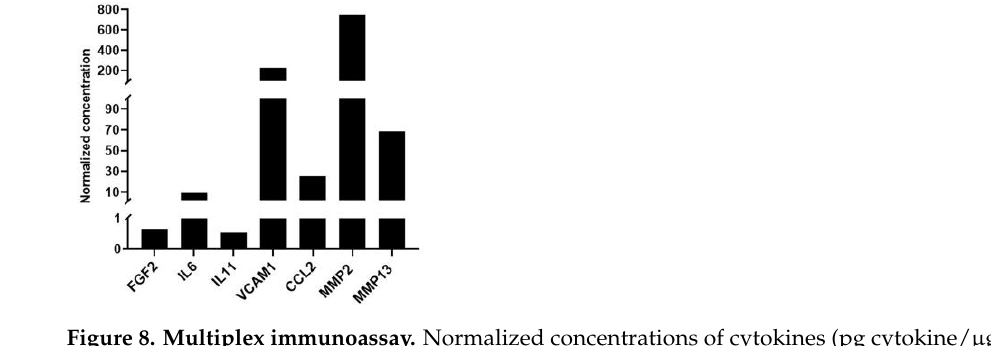
Figure 8. Multiplex immunoassay. Normalized concentrations of cytokines (pg cytokine/ µ g total protein) detected in CM using a human bone metabolism array (Supplementary Table S3). Data represent means of 4 technical replicates of a single sample of pooled CM (3 MSC donors).